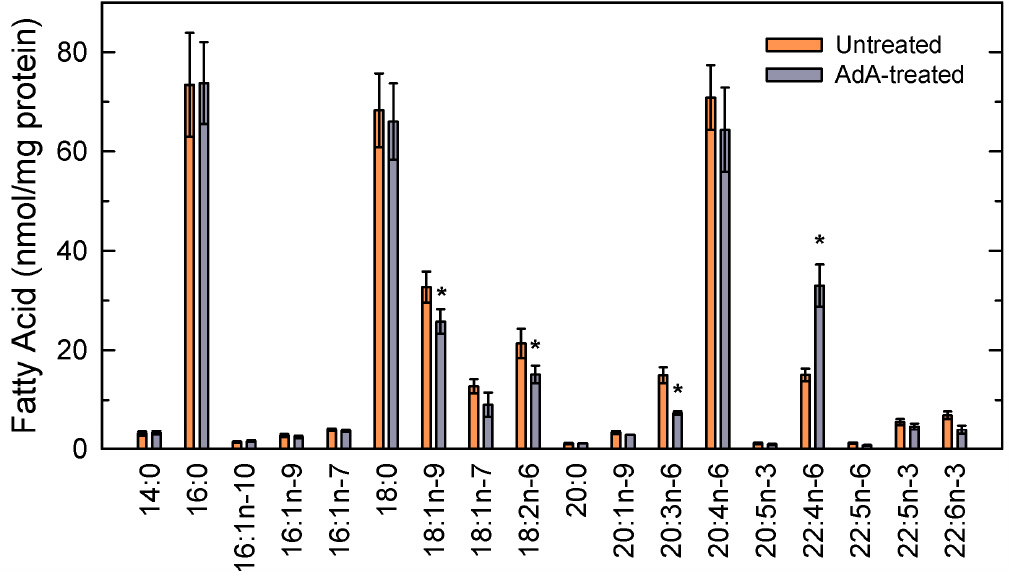
Figure 5. Fatty acid composition of murine peritoneal macrophages. The cells were either untreated (orange bars) or treated with exogenous AdA for 20 h (gray bars). Afterward, the total fatty acid profiles in cells were determined by GC/MS after converting the fatty acid glyceryl esters into fatty acid methyl esters. The fatty acids are designated by their number of carbon atoms, and after a colon, their number of double bonds. To differentiate isomers, the n − x (n minus x) nomenclature is used, where n is the number of carbons of a given fatty acid and x is an integer that gives the position of the last double bond of the molecule when subtracted from n. The data are expressed as mean values ± standard error of the mean of three individual replicates. Note: * p < 0.05, significantly different from incubations in the absence of AdA.